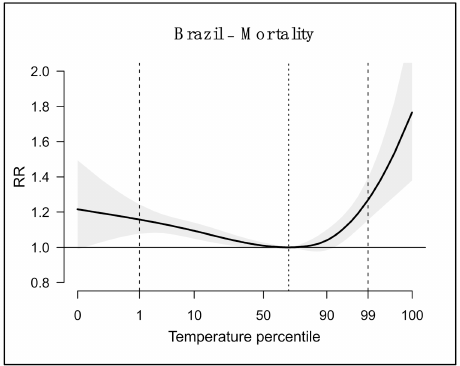
Figure 2. Pooled overall cumulative exposure–response association curve between temperature and mortality. Brazil, capitals, 2000 to 2017. Note: dotted line is the percentile of the minimum risk temperature; dashed lines at 1st and 99th percentiles of the temperature